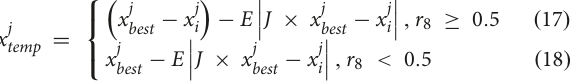
Algorithm 1. Pseudo-code of the soft besiege